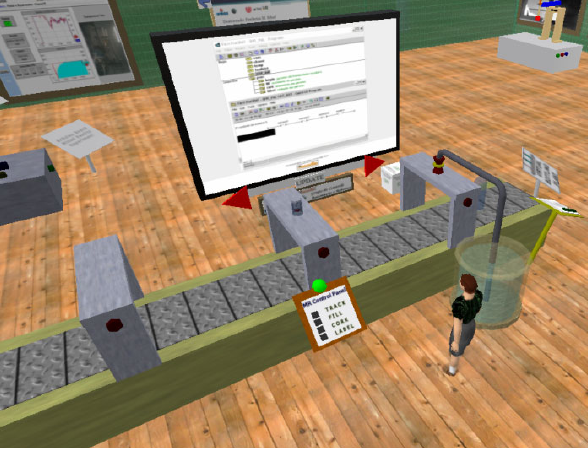
Figure 4. Learning material display and experiment interface